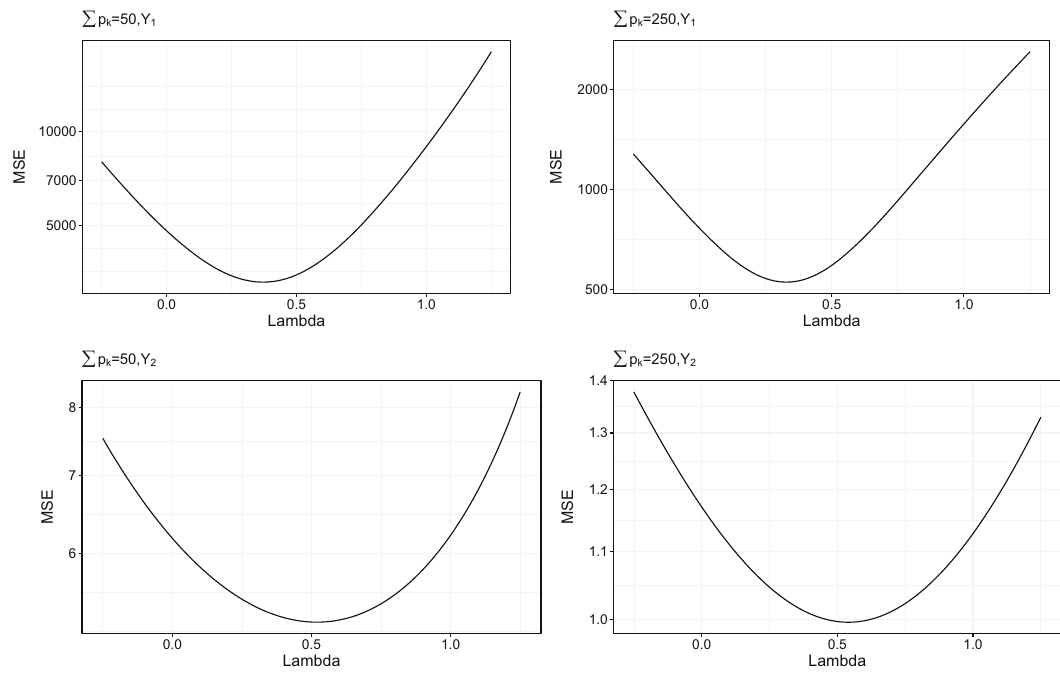
as a function of λ for the four problem speci fi cations of the Swiss municipality Figure A1: MSE of μ ˆ λ